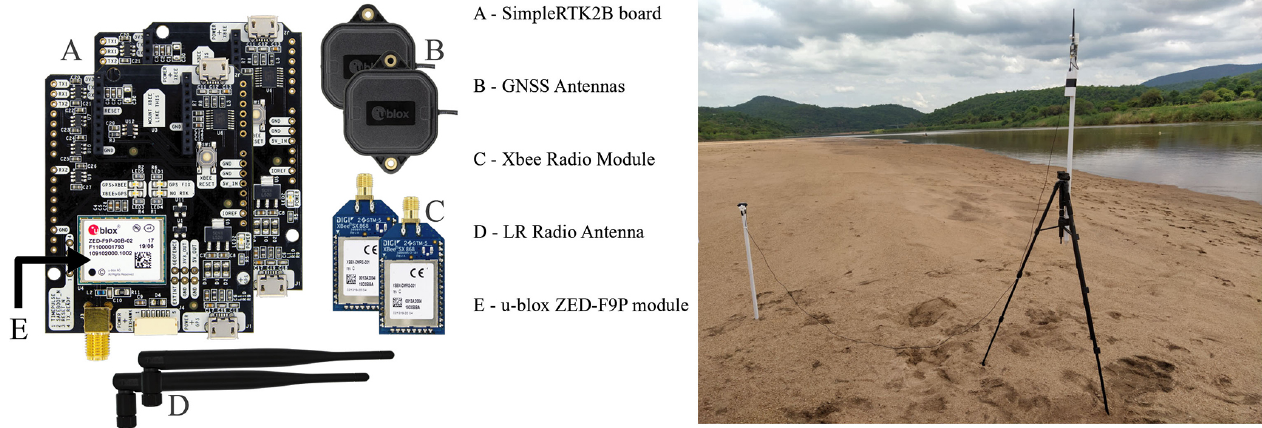
Figure 2. (a) RTK GNSS set and (b) RTK GNSS base station setup along the Luangwa River floodplain.